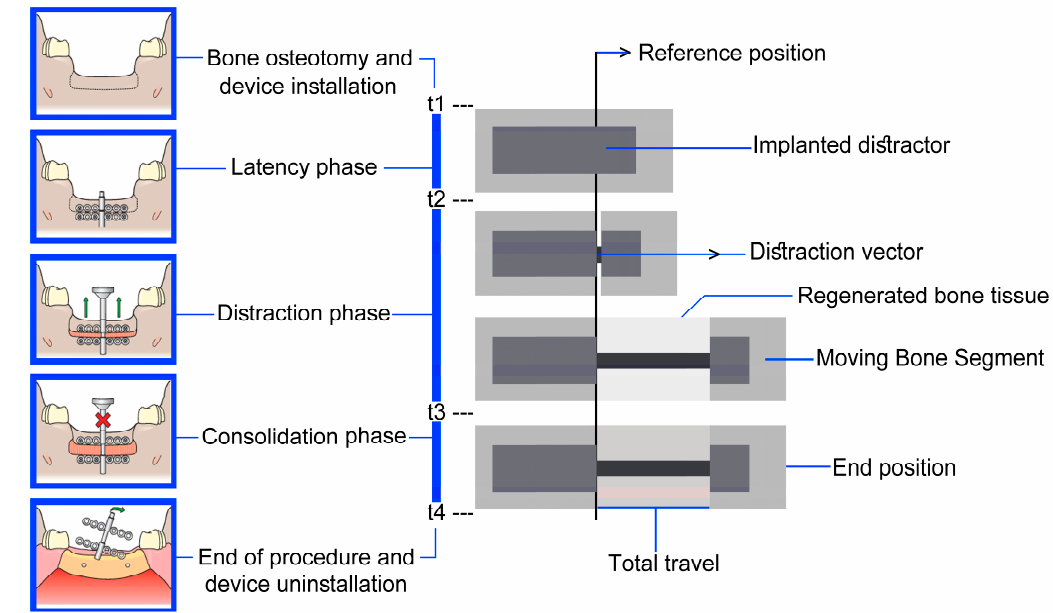
Figure 1. The standard DO method in MRA [7].